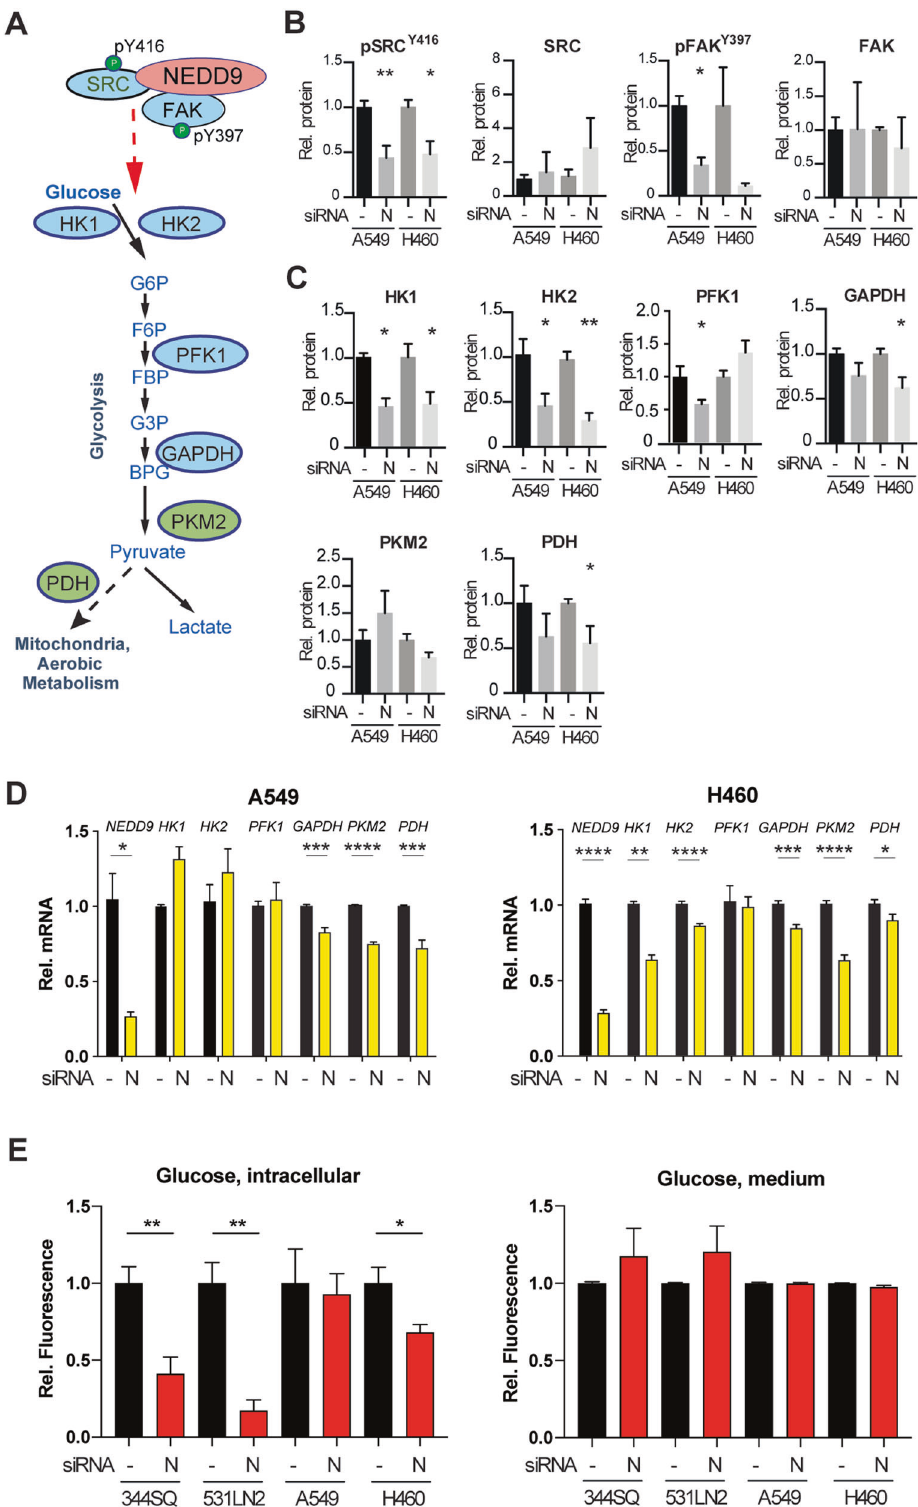
Fig. 2 Depletion of NEDD9 in NSCLC cells reduces expression and activity of hexokinases and other glycolytic enzymes. A Schematic of proteins that regulate and mediate glycolysis. B Western blot analysis of total and active phosphorylated (pSRC Y416 , pFAK Y397 ) SRC and FAK following treatment with siRNAs depleting NEDD9 (N) protein or Scrambled control (-). C Western blot analysis of proteins indicated, following NEDD9 depletion. D qRT-PCR analysis of steady-state mRNA for genes indicated in NEDD9-depleted (N) or scrambled siRNA-treated (-) cells. E Levels of intracellular glucose (left) and glucose in culture medium (right) in cells treated with siRNAs depleting NEDD9 (N) or Scrambled control (-). Data are normalized for each cell line to cells treated with Scr siRNA. * p < 0.05, ** p < 0.01; error bars represent SEM.